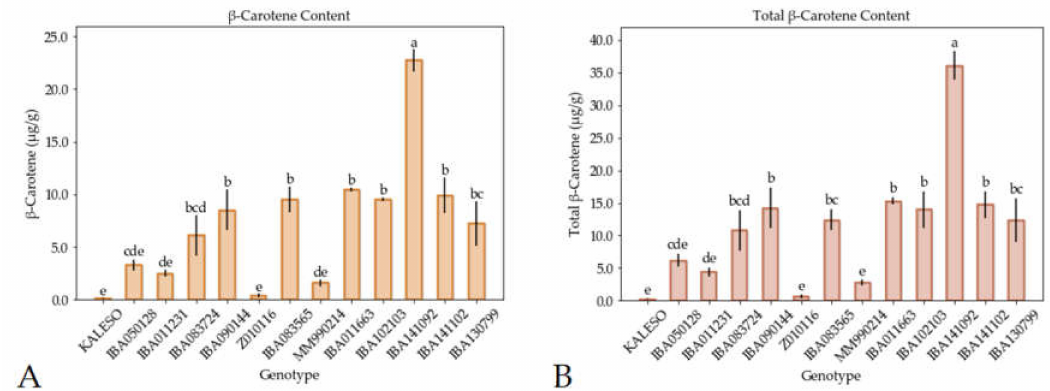
Figure 3. ( A ) All-trans β -carotene concentration in µ g g –1 dry weight of cassava. ( B ) Total β -carotene in µ g g –1 dry weight of cassava. Error bars represent the standard deviation from the mean. Groupings generated from ANOVA and Tukey adhoc tests are above each